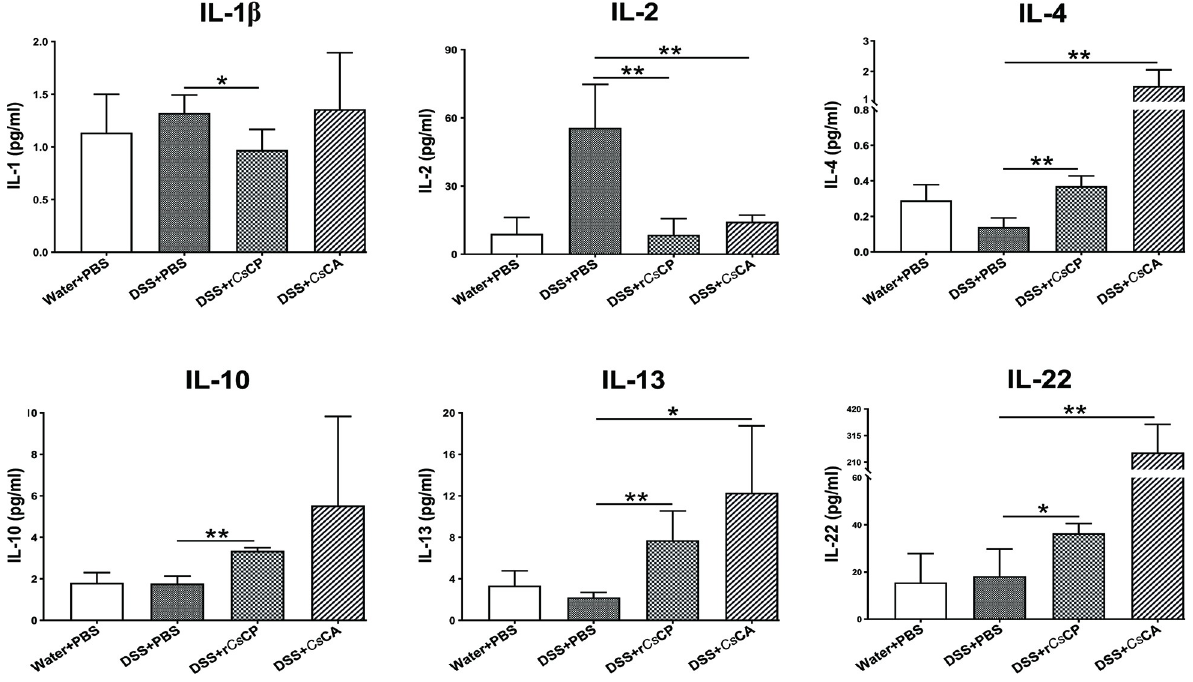
Fig 5. The secretion of inflammatory-related cytokines in serum of different treatments mice. On the 7th day of the experiment, mice were sacrificed to separate serum, and the levels of cytokines, such as IL-1 β , IL-2, IL-4, IL-10, IL-13 and IL-22, were measured by ELISA. Data are presented as mean ± SEM (n = 4). � P < 0.05, �� P < 0.01.